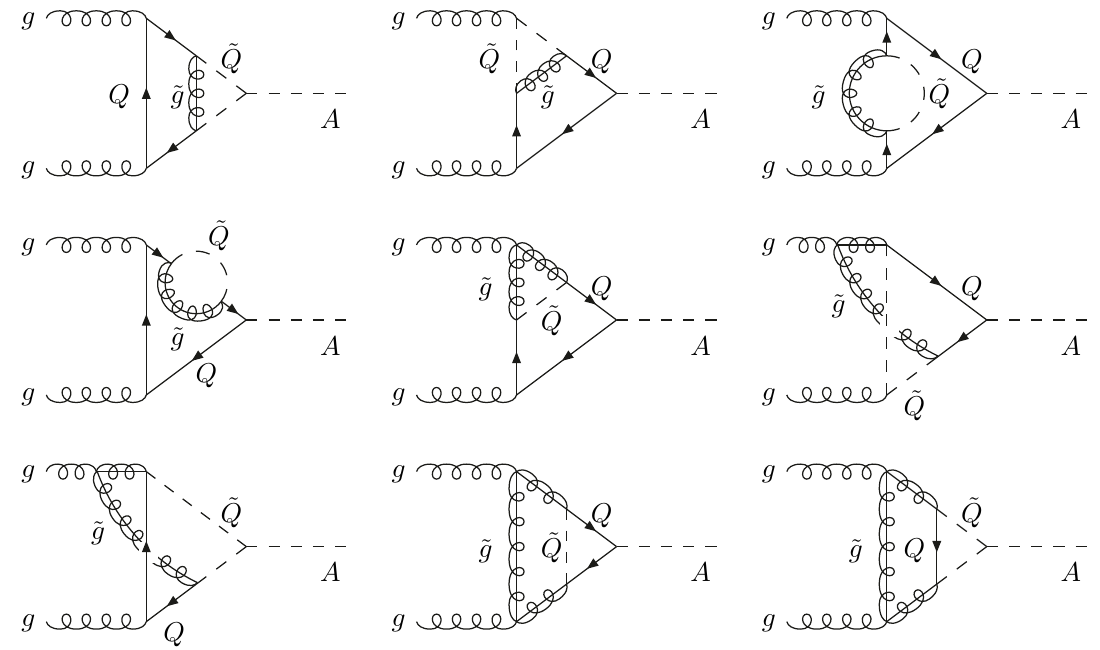
Figure 5 . Non-vanishing diagrams contributing to the genuine SUSY-QCD corrections to pseu- doscalar MSSM Higgs boson production via gluon fusion mediated by top- and bottom quark ( Q = t, b ) as well as stop/sbottom ( ˜ Q = ˜ t, ˜ b ) and gluino ( ˜ g ) loops at